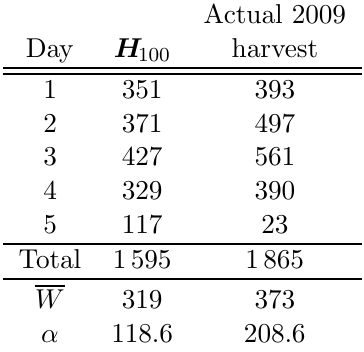
Table 2: An analysis of the mass of grapes scheduled for intake during a five-day period for the harvesting schedule H 100 and the actual 2009 harvesting schedule implemented at Wamakersvallei Winery. Here W denotes the average mass of grapes received per day and α denotes the standard deviation of these daily